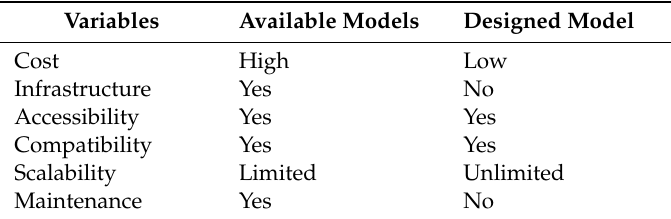
Table 3. Comparison of cloud models.